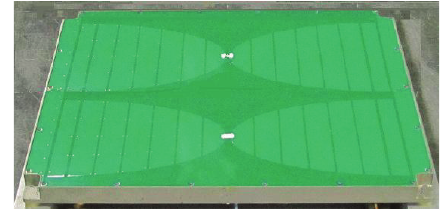
Figure 4: Fabricated antenna model.